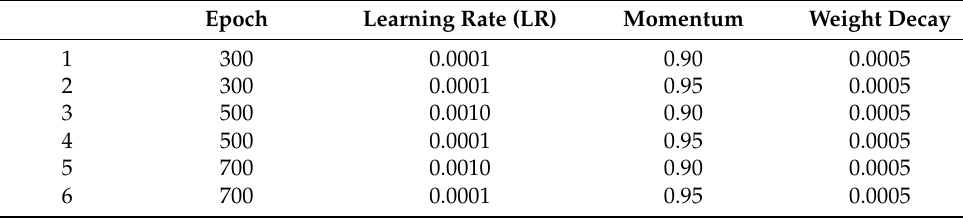
Table 2. Hyperparameter